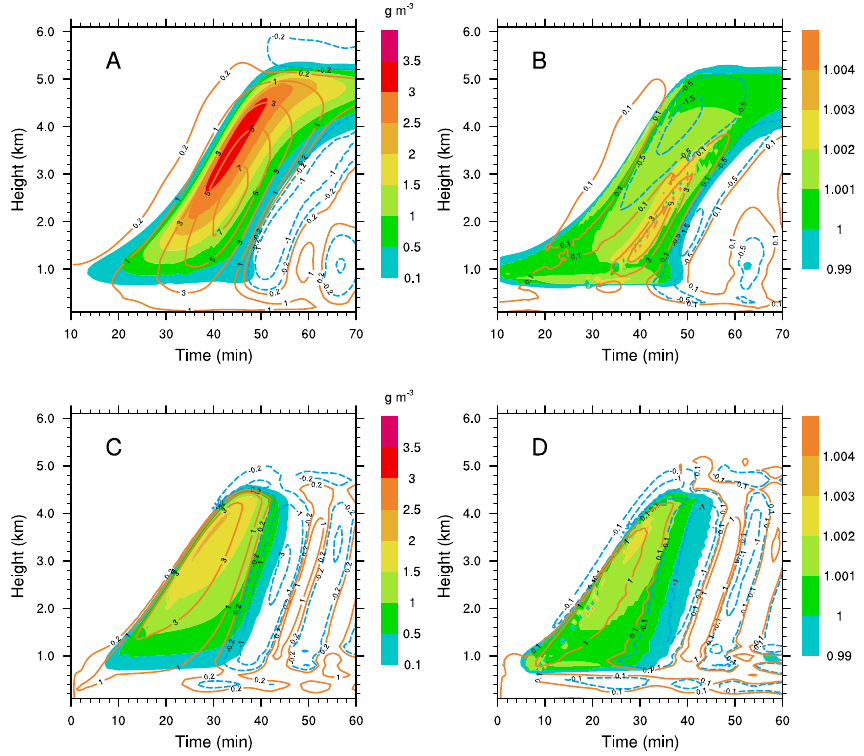
Fig. 1. Spatial and temporal evolution of thermodynamic variables with perturbation pressures (A, B) and with perturbation pressures omitted (C, D) . (A) and (C) Liquid water content (in gm − 3 ) (shaded area) and vertical velocity (ms − 1 ) (solid and dashed lines) as a function of time and height. (B) and (D) Supersaturation ratio and net vertical acceleration dw / dt (cms − 2 ) (solid and dashed lines) as a function of time and